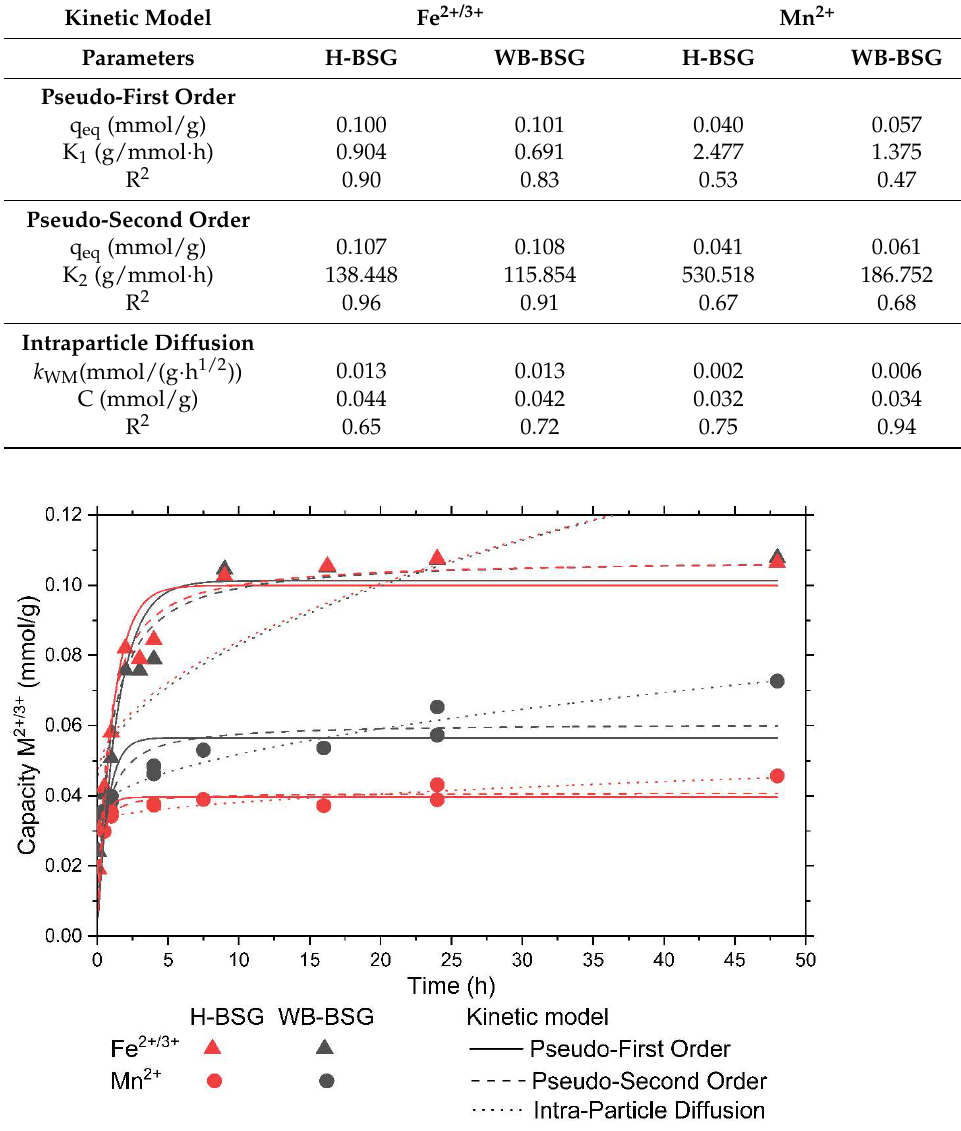
Table 3. Fitting parameters for Fe 2+/3+ and Mn 2+ adsorption onto H-BSG and WB-BSG for different kinetic models. Data from batch experiments as presented in Figure 5.